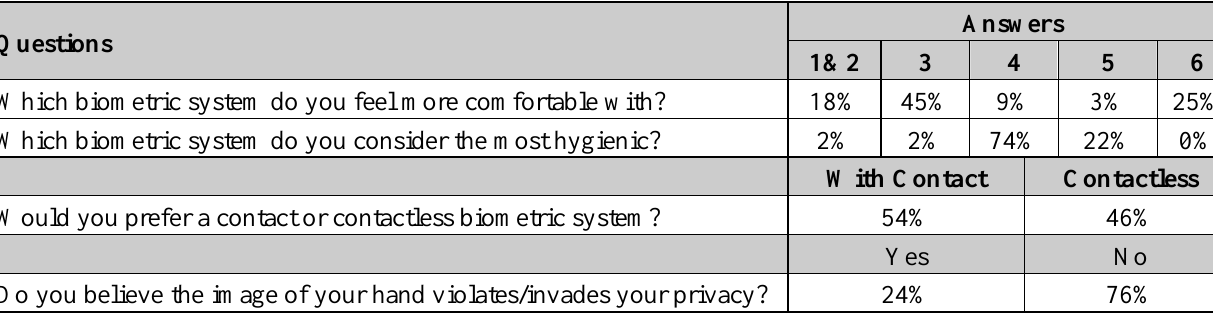
Table 11. Survey about the acceptance and interoperability of the hand biometrics approaches